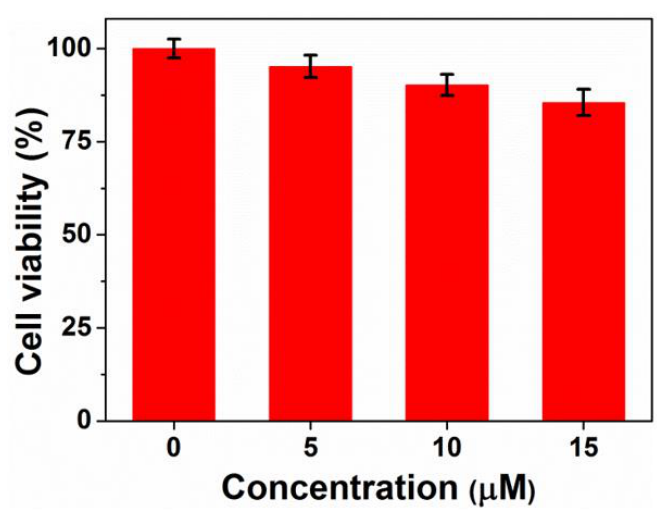
Figure 10. Cell viability of L929 cells after 24 h incubation with different concentrations of the PEG-acrylic rosin polymer.